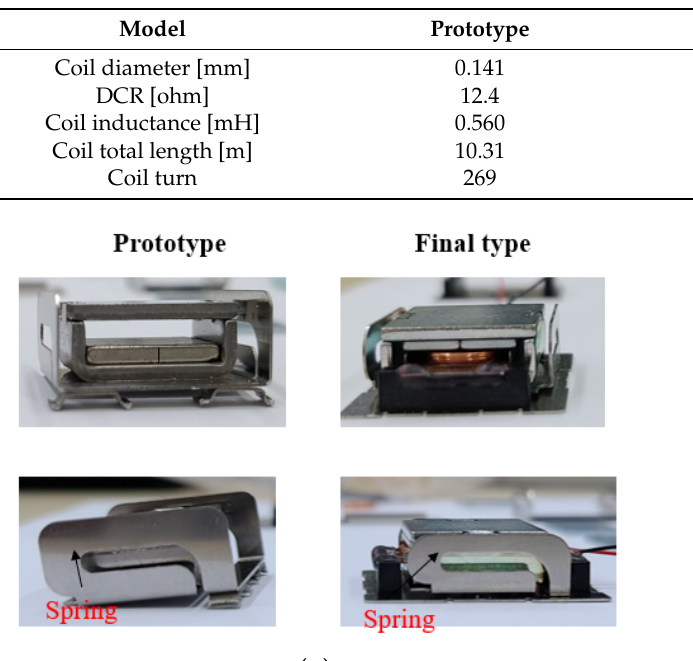
Table 3. Voice coil specification comparison.